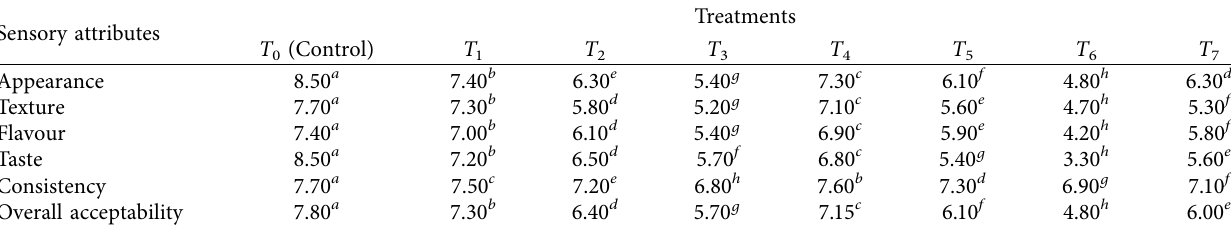
Table 8: Effect of adding apple pomace powder and pomegranate peel powder on the sensory profile of yogurt. Values are given in (mean ± SD).